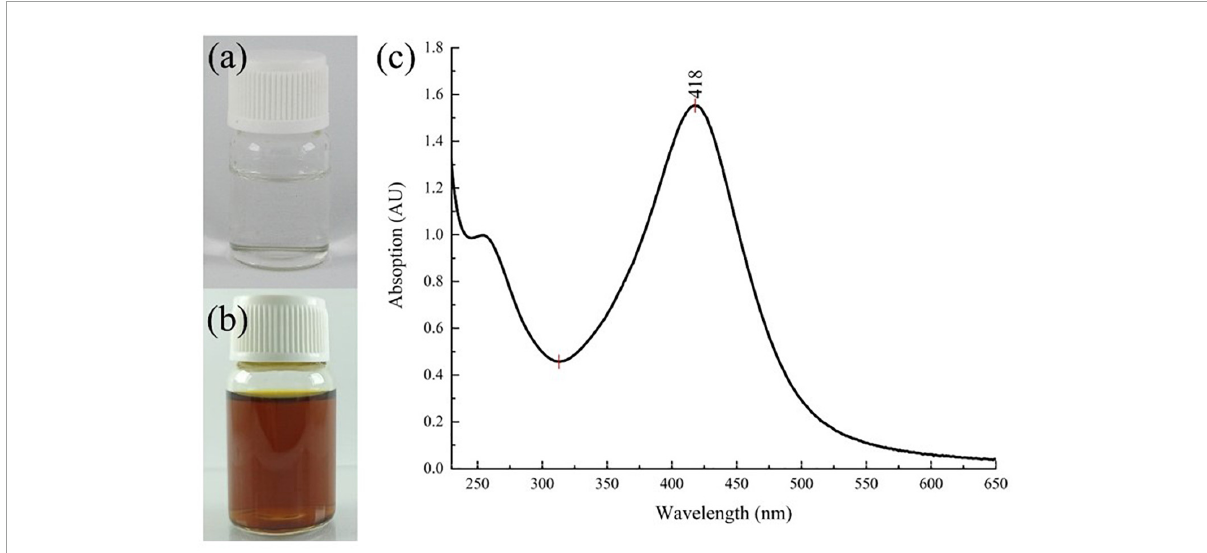
FIGURE2 Color change of the reaction system (a) before and (b) after gamma irradiation and (c) the UV–Vis spectrum of colloidal AgNPs. AgNPs, silver